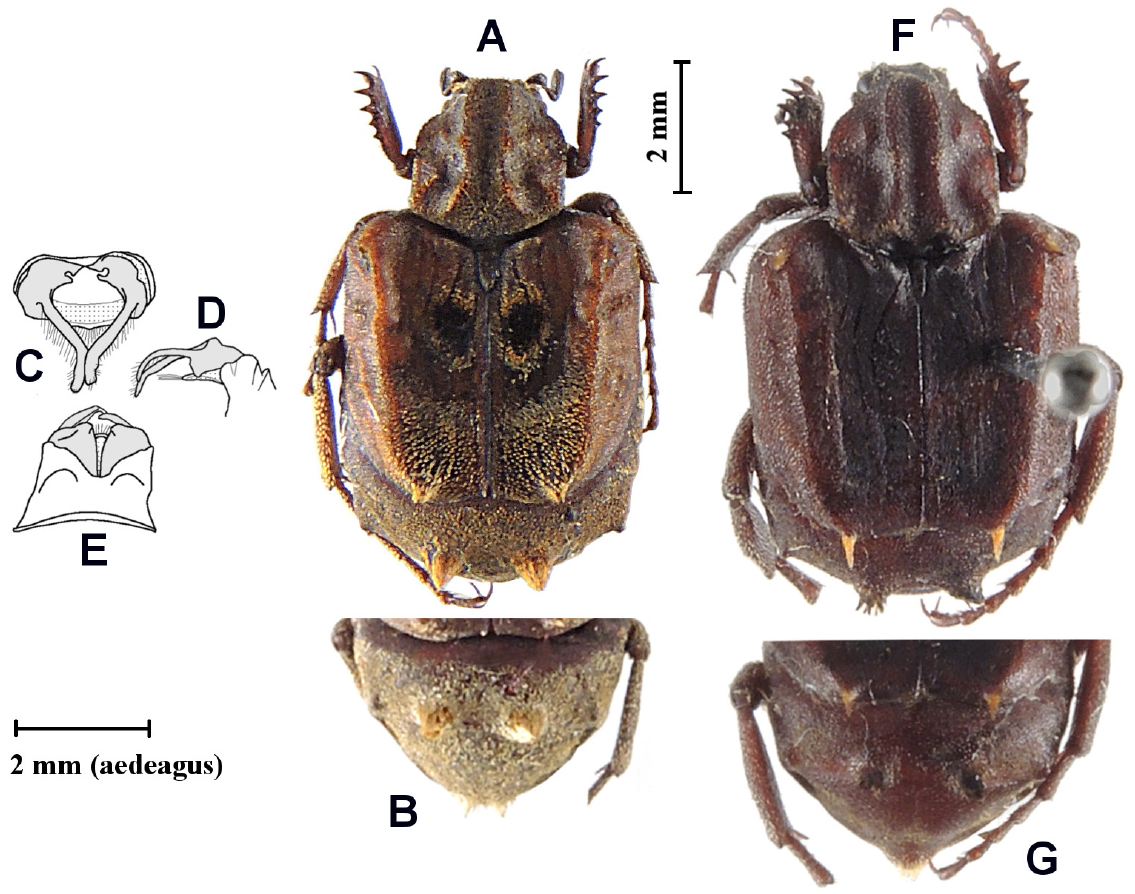
Fig. 5. Hybovalgus bioculatus Kolbe, 1904 (ERC). A–E . ♂. A . Habitus, dorsal view. B . Propygidium and pygidium. C–E . Aedeagus (grey: parameres; white: phallobase). C . Dorsal view. D . Lateral view. E . Posterior view. F–G . ♀. F . Habitus, dorsal view. G . Propygidium and